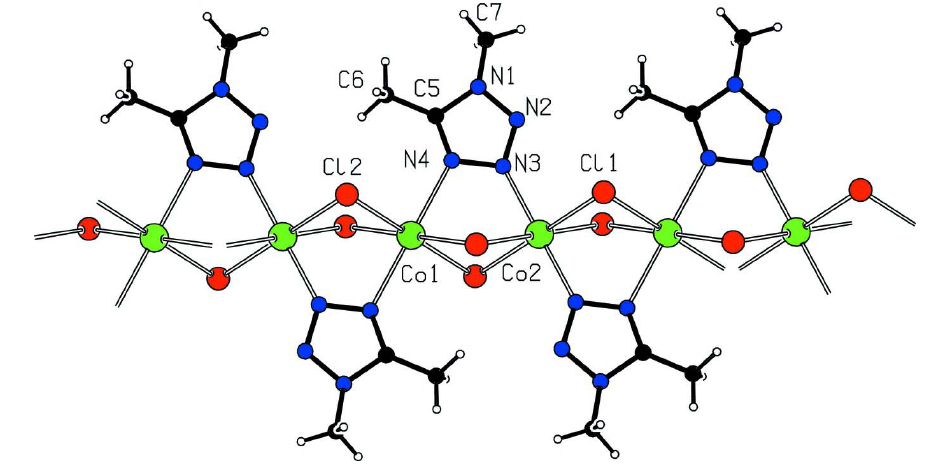
Figure 1 A portion of the polymeric chain of (I) running along the a axis. The atomic numbering scheme is given for the asymmetric unit.